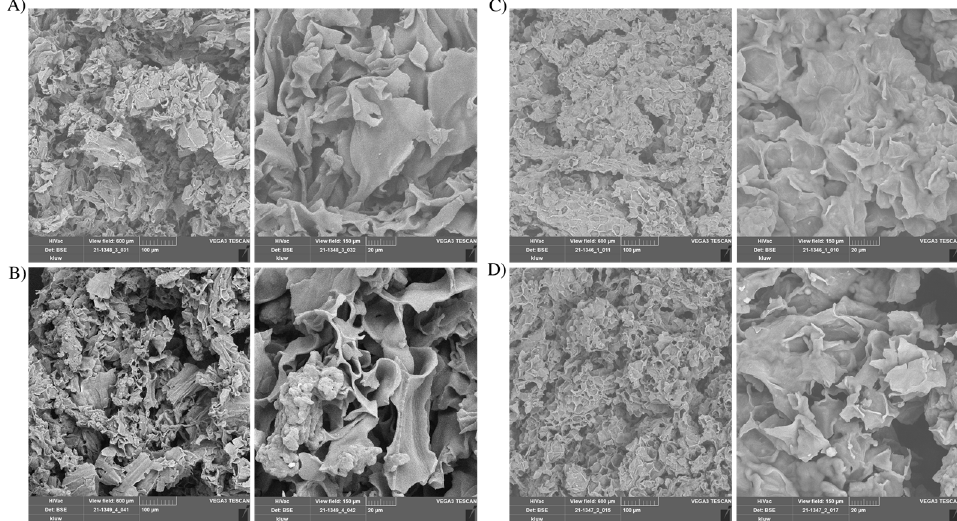
Figure 1. Comparison by the SEM of raw and ultrasound treated press cakes at two different magnifications (left 300× and right 1500×). ( A ) Raw coconut press cake; ( B ) ultrasound treated coconut press cake; ( C ) raw almond press cake; ( D ) ultrasound treated almond press cake.